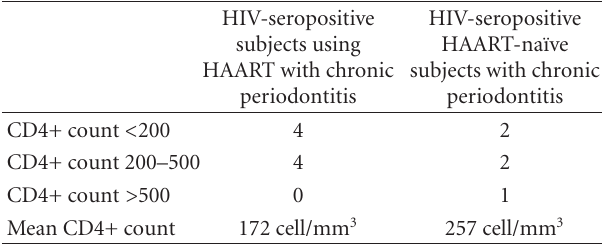
Table 3: The categories of CD4+ T-cell levels of the HIV- seropostive subjects using HAART and HIV-seropositive HAART- na¨ıve